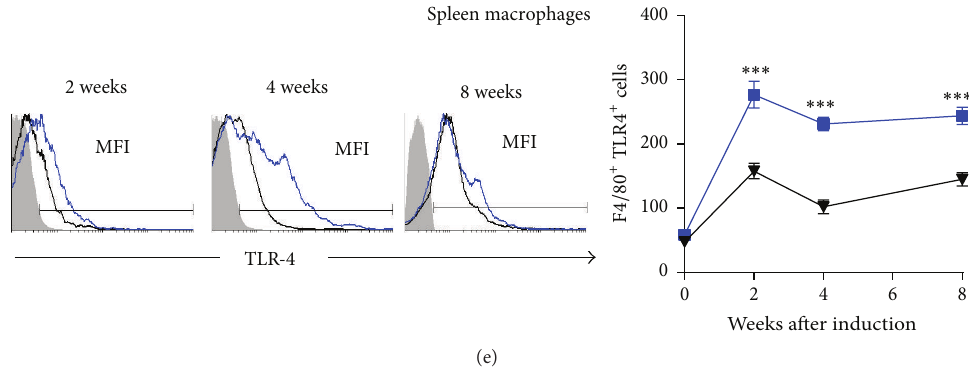
Figure 5: Mif promotes costimulatory molecule expression on spleen M 𝜑 . The time course of costimulatory molecule: CD80 (a), CD86 (b), MHC-II (c), TLR-2 (d), and TLR-4 (e) expression on spleen F4/80 + M 𝜑 . M 𝜑 from spleen of Wt and Mif − / − mice were harvested at 0, 2, 4, and 8 weeks after STZ administration and 1 × 10 7 cells/mL were processed by flow cytometric analysis as indicated in Section 2. Analyses of expression are shown in the right panels: WtSTZ ( ◼ ); Mif − / − STZ ( 󳶃 ). And representative histograms of expression based on fluorescence are shown in the left panels; isotype controls are indicated in gray shadow, the black line represents expression by Mif − / − STZ cells, and the blue line shows expression by WtSTZ cells. The data are presented as the mean fluorescence intensities (MFI) from one representative experiment. Each experiment was repeated three times ( 𝑛 = 3 ) and individually analyzed. ∗ 𝑝 < 0.05 , ∗∗ 𝑝 < 0.01 , or ∗∗∗ 𝑝 < 0.001 , GraphPad Prism software